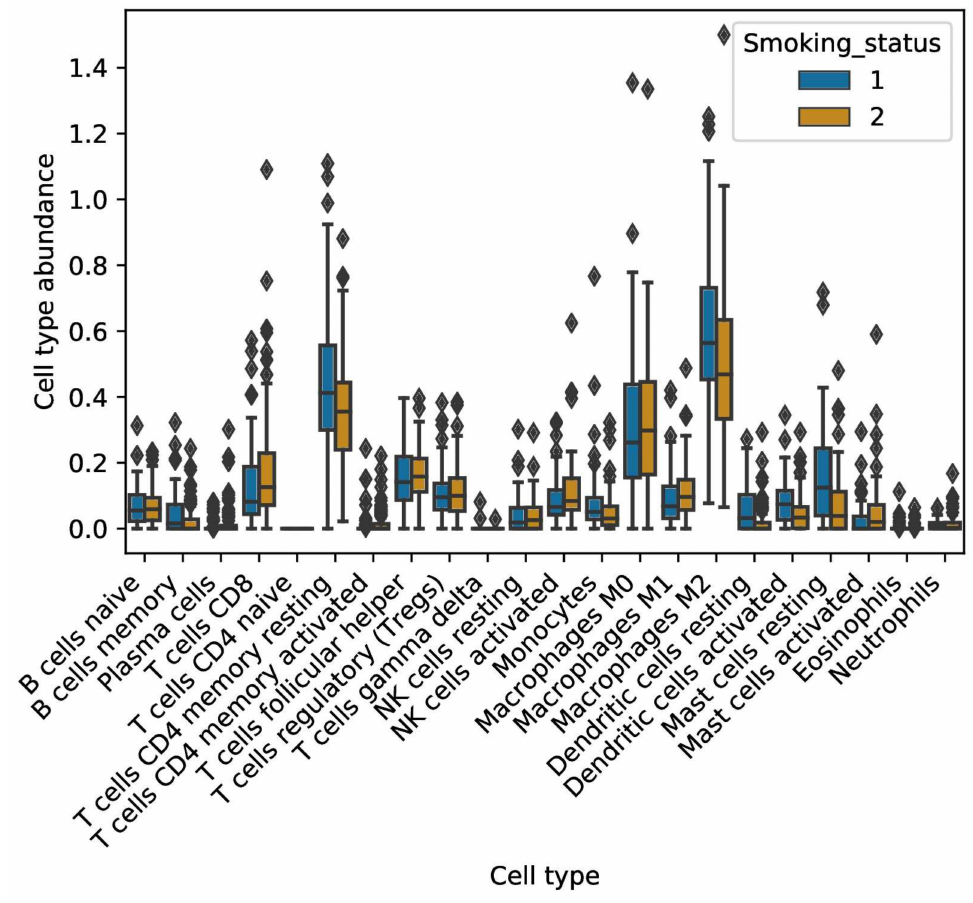
Figure 6. Immune profile of smokers affected with lung adenocarcinoma. Various immune cells profiles were analyzed in non-smokers (1) compared to smokers